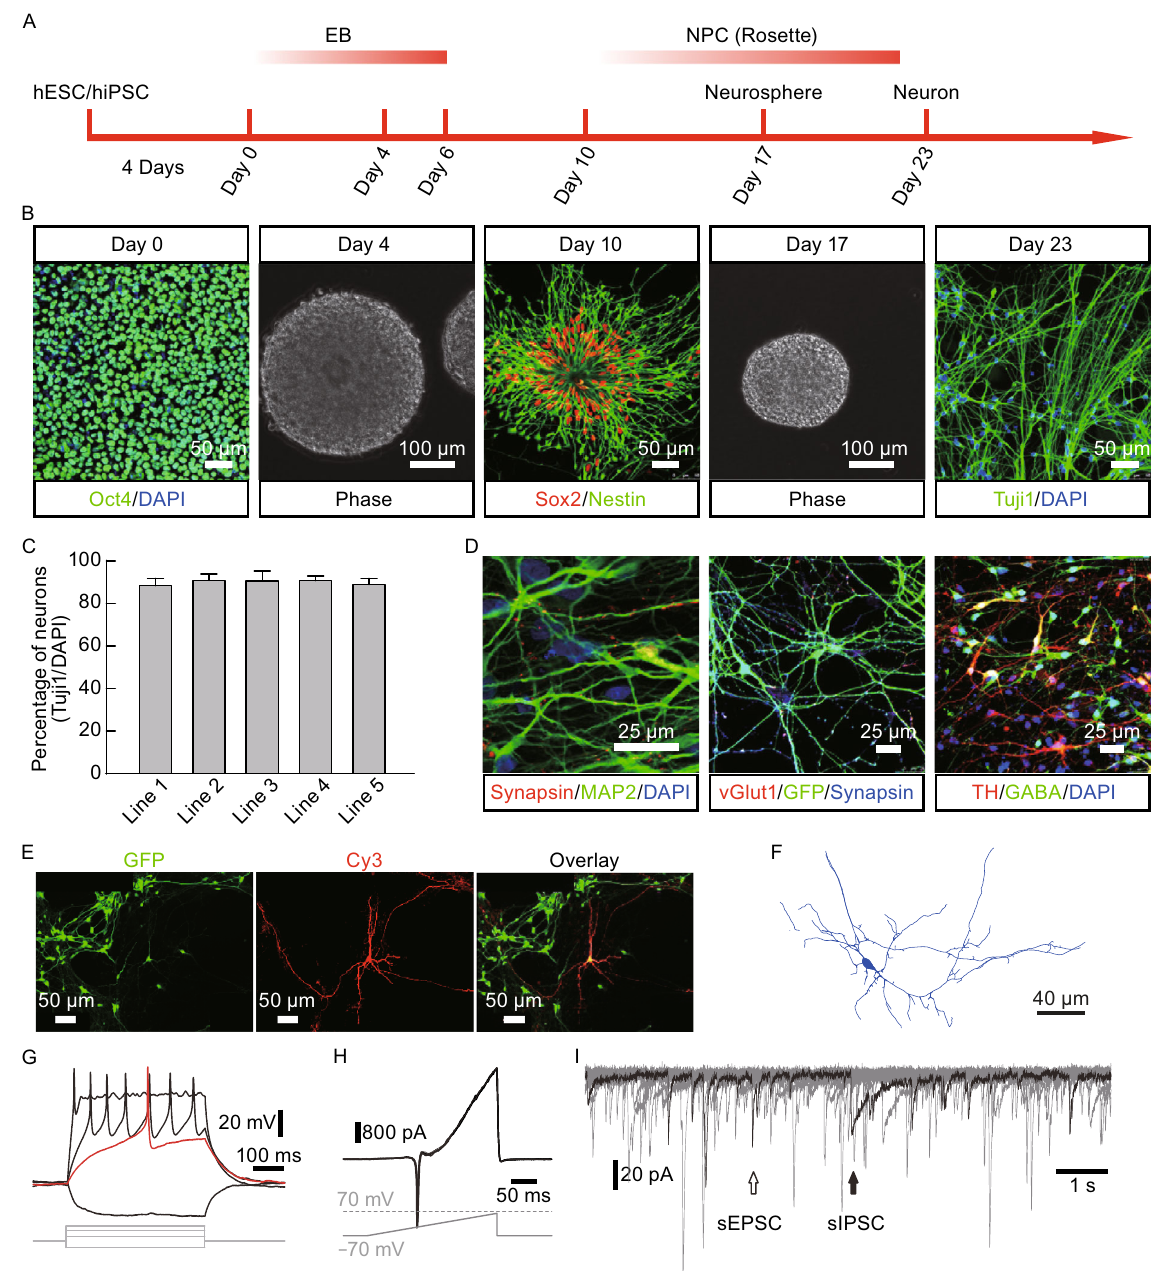
Figure 1. Generation of functional neuron via differentiation of hESC/hiPSC/fetal tissue-derived NSCs. (A) Diagram of the neuronal differentiation protocol (see experimental procedures for details). (B) Representative images showing morphological changes during neural differentiation. hESC/hiPSC are positive for pluripotent markers Oct4. Neural stem/progenitor cell (NSC/NPC) colonies, showingrosettestructures,arepositiveforneuralprecursormarkersSox2andNestin,whereasneuronsarepositiveforTuj1(Bar:100or50 μ m). (C) Percentage of Tuj1 positive cells showing similar pan neuronal differentiation potentials of different hESC/hiPSC lines. (D)Representativeimagesofmatureneurons,co-culturedwithmouseastrocytes,showingexpressionofMAP2,Synapsin,vGlut1,TH,and GABA (Bar: 25 μ m). (E) Representative images of a recorded neuron injected with neurobiotin and immunostained (Cy3), surrounded by other GFP expressing lentivirallyinfected neurons. Bar represents 50 μ m. (F) A representative reconstructed image ofneurons. Scale bar represents40 μ m.(G)RepresentativeactionpotentialresponsesofahiPSC-derivedneuronevokedbycurrentinjection(Bars:100msand 20 mV). (H) Representative traces from a hiPSC-derived neuron showing inward sodium currents and outward potassium currents in responsetoarampprotocol(from − 70mVto+70mV).Threesuperimposedtracesareshown(Bars:50msand800pA).(I)Representative traces from a hiPSC-derived neuron showing spontaneous postsynaptic currents (sPSCs). Ten traces are superimposed. Black arrow, inhibitory sPSC; white arrow, excitatory sPSC (Bars: 1 s and 20